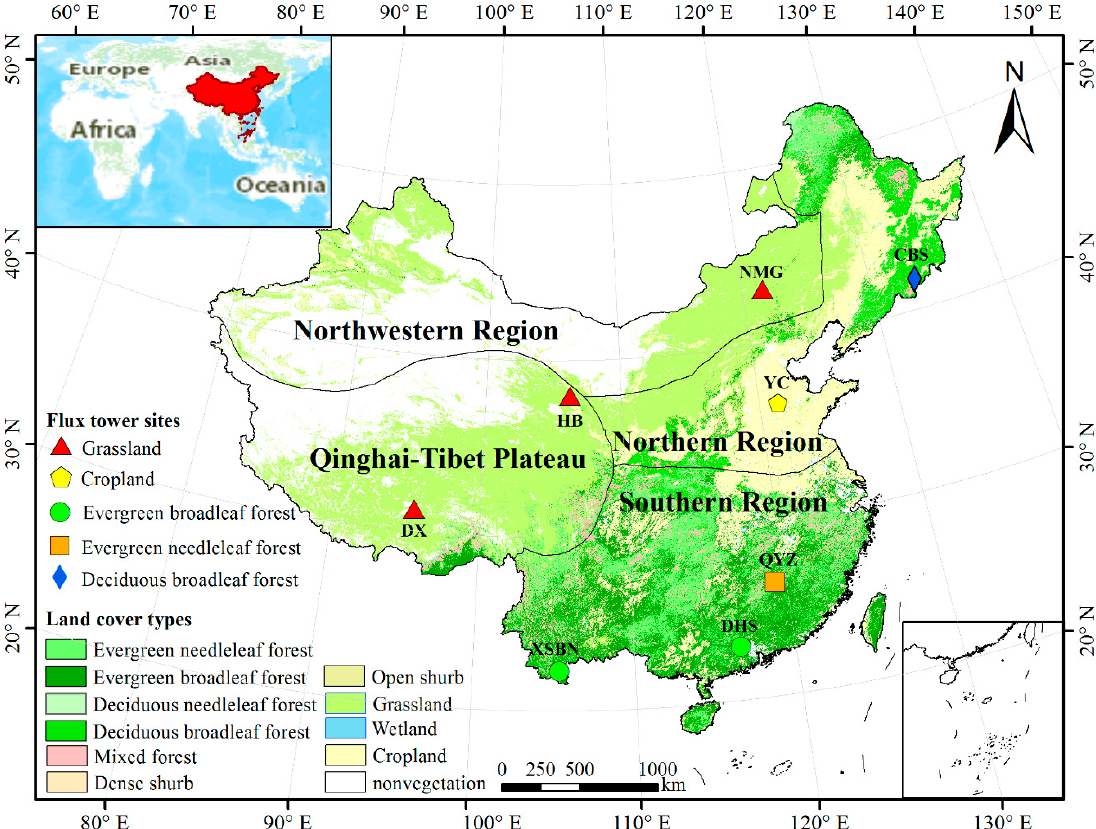
Figure 1. Land cover types, the locations of the eight flux tower sites and the distribution of the four geographical regions.